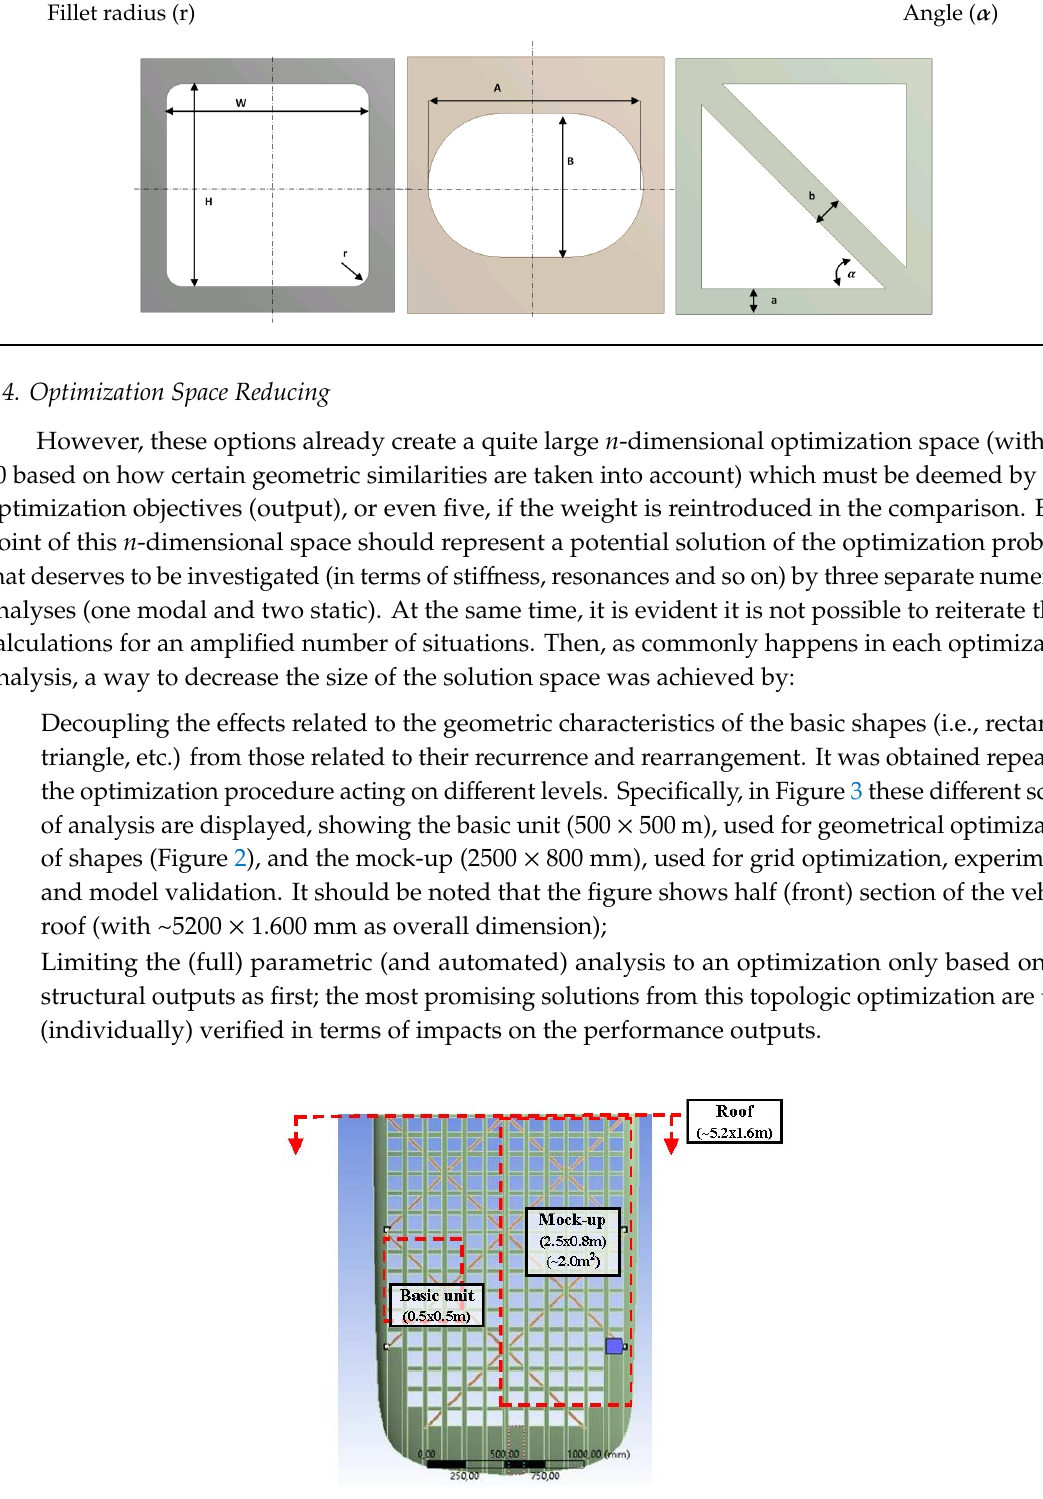
Figure 3. Different scales of analysis: basic unit (500 × 500 m), experimental mock-up (2500 × 800 mm) and half (front) section of the roof (~5200 × 1.600 mm).